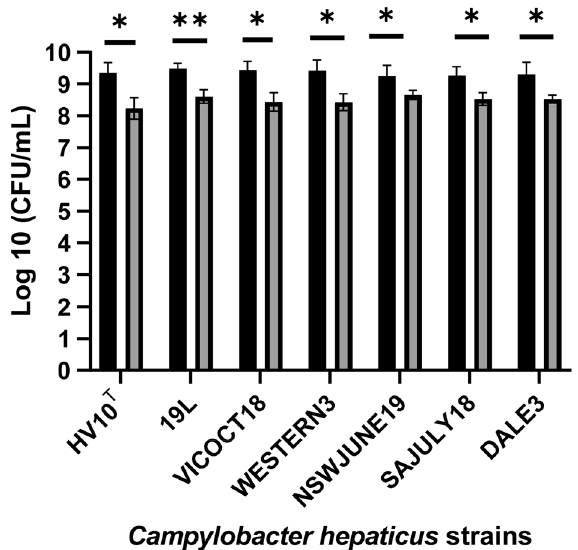
Figure 4. Growth of C. hepaticus isolates in modified Brucella broth (Brucella broth supplemented with 0.4 mM l-cysteine, 4 mM l-glutamine and 10 mM sodium pyruvate) compared to non-supplemented Brucella broth after 48 h of incubation under microaerobic conditions. Solid black bars illustrate the growth of C. hepaticus strains in modified Brucella broth, grey bars in Brucella broth only. P values were calculated using unpaired t-tests. Significant difference *: p ≤ 0.05. **: p ≤